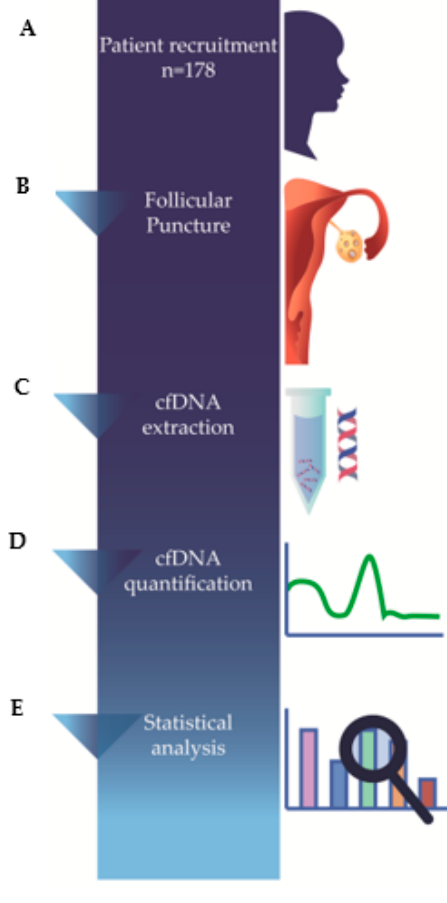
Figure 1. Schematic summarization of methods. A total of 178 FF samples were collected ( A ); oocyte retrieval was performed by follicular puncture by transvaginal ultrasound-guided aspiration, 36 h after the injection of human chorionic gonadotrophin ( B ); samples were centrifuged, supernatants were filtered and digested with PK, followed by PK heat inactivation and insolubilization ( C ); cfDNA was quantified by qPCR, using ALU115 and ALU247 primers ( D ); statistical tests were performed using Statistical Package for the Social Sciences (SPSS ® ) for Windows (version 24), IBM Corp., Amonk, NY, USA and results were considered significant when p ≤ 0.05 ( E ).